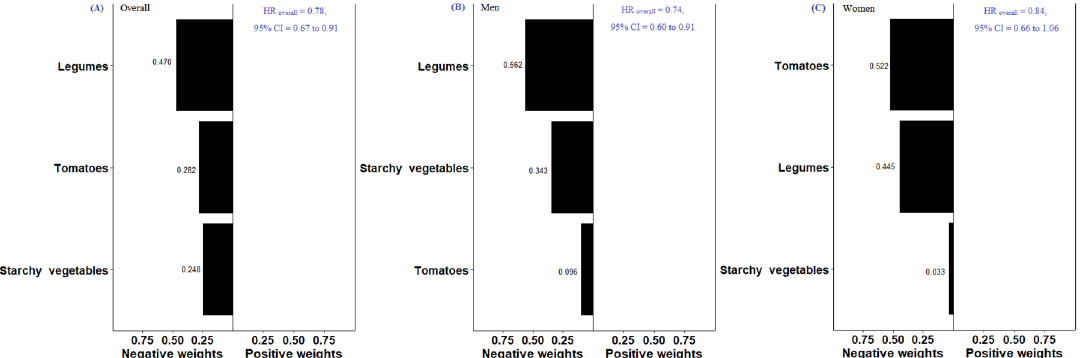
Figure 2. Weights representing the proportion of the positive or negative partial effect for each food group on CVD-mortality risk in the Quantile G-Computation Overall ( A ), Men ( B ), and Women ( C ). Model adjusted for sex, age, dietary energy, body mass index, physical activity, systolic blood pressure, medical history (diabetes, hypertension, stroke, heart attack, angina, congestive heart failure or cancer), smoking habits, alcohol drinking, and education